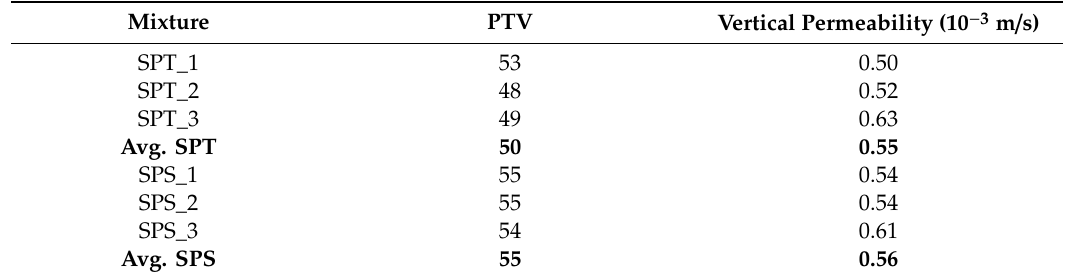
Table 7. Average Pendulum Test Value (PTV) and vertical permeability results.